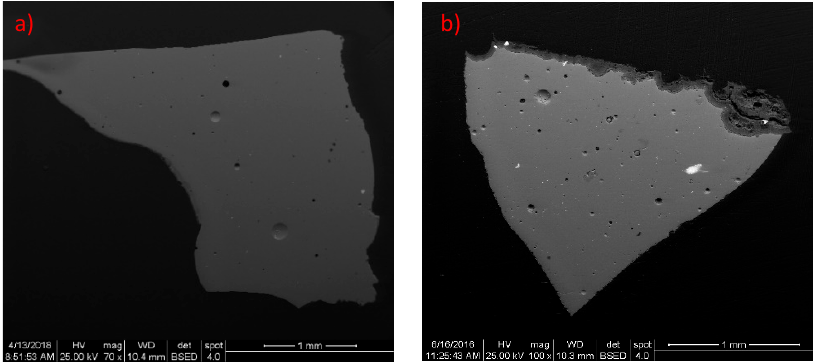
Table 1. Antimony-Based Phases.